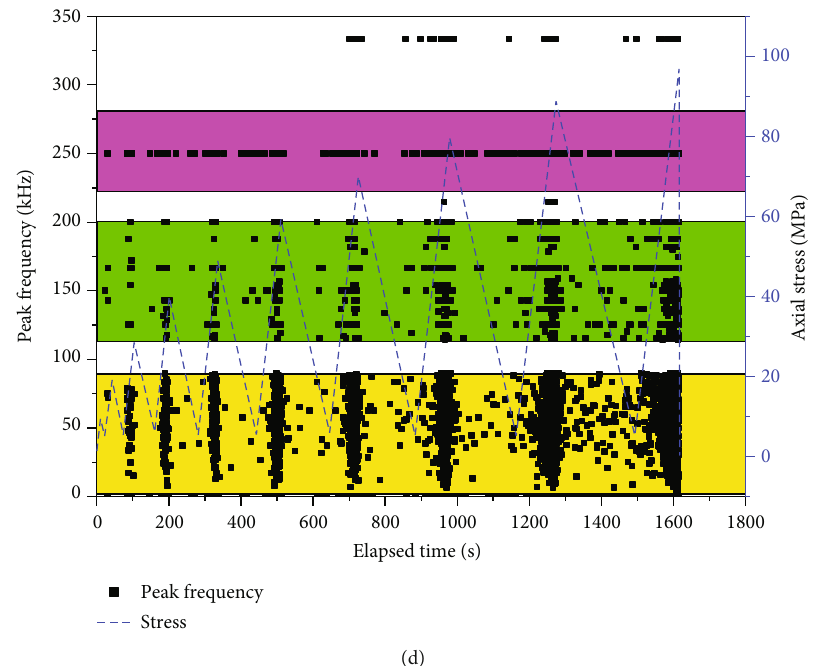
Figure 17: The main frequency characteristics of the tested samples during fracturing. (a – d) The sample IDs are NFG-34, NFG-24, NFG-21, and NFG-30, respectively. The corresponding natural fracture volume ratios are 0.19%, 0.15%, 0.13%, and 0.11%, respectively. Table 2: Frequency spectrum characteristics of the tested granite sample during whole fracture process. Sample ID